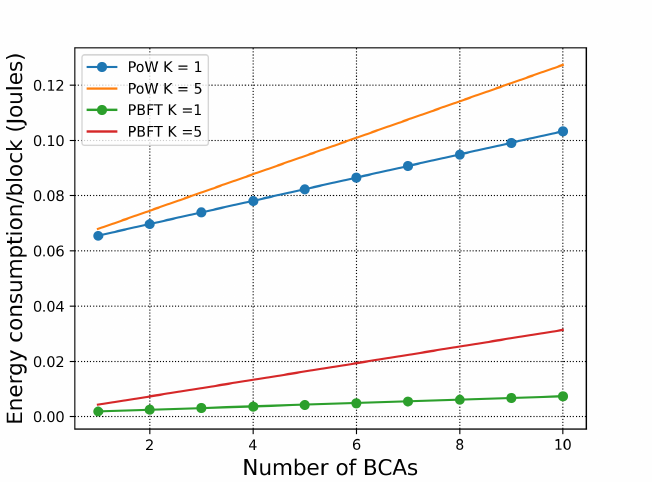
Figure 2. Total energy consumption per block with respect to the number of BCAs. γ ∗ : γ (cid:48) = 100 : 1, D =